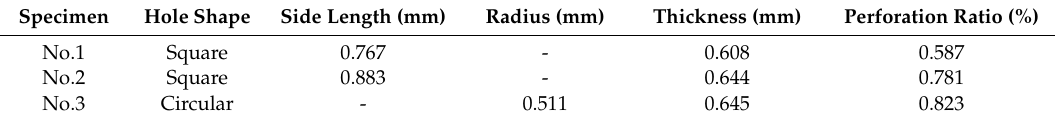
Table 2. Measured parameters of the resulting specimens made by 3D